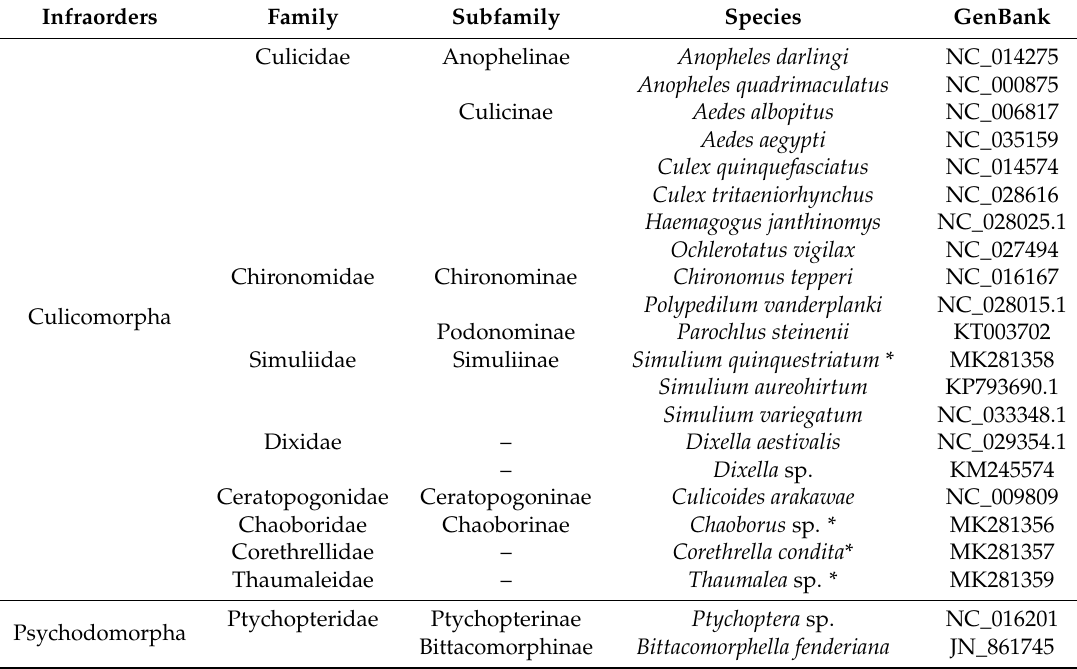
Table 1. Summary of taxonomic groups used in this